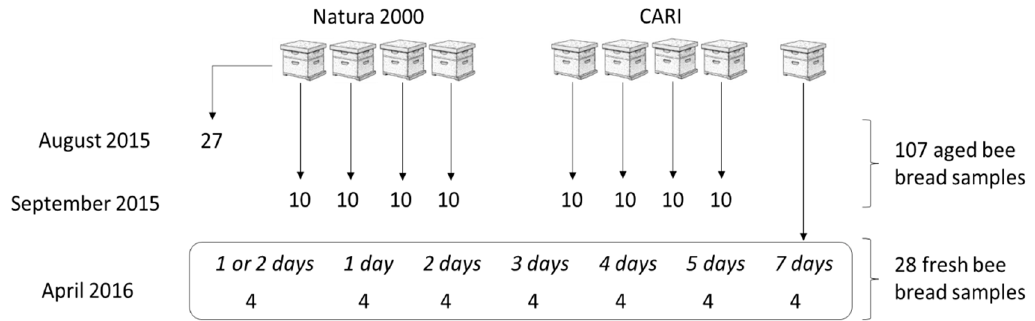
Figure 1. Numbers of pollen samples obtained from two apiaries located in Belgium in a Natura 2000 site, Chaumont-Gistoux and in a mixed zone with agriculture and small industry (CARI) in Louvain-la-Neuve. Samples originated from nine hives and are distinguished into aged ( > 20 days) and fresh bee bread ( ≤ 7 days).